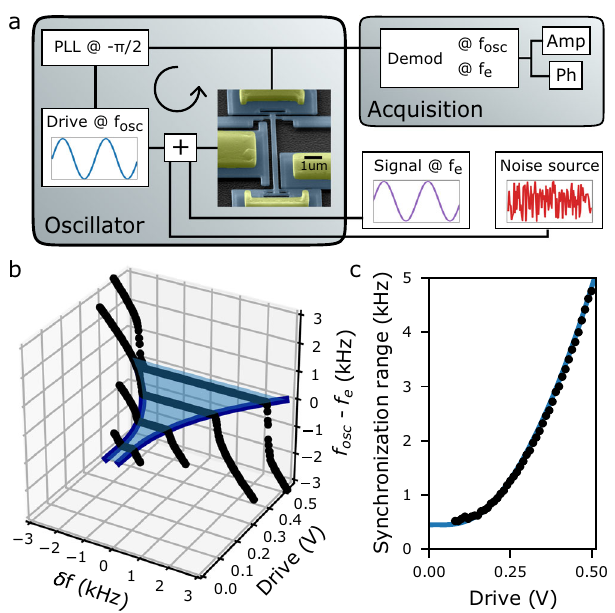
Fig. 1 Experimental setup and synchronization regime. a The resonator (colored scanning electron micrograph of a representative NEMS in inset) is driven as an oscillator at f using a feedback loop (arrow), and is subject osc to an external tone at f e . Using a lock-in ampli fi er, the output signal of the NEMS is demodulated at either f osc or f e to obtain amplitude and phase difference. The noise source is turned off for the synchronization range characterization. b The oscillator gets synchronized and locked to the frequency f e for a suf fi ciently small frequency mismatch δ f ¼ f r (cid:2) f e . c The synchronization range increases quadratically with the drive amplitude in the nonlinear regime. The external tone level is set to 10% of the drive. The experimental black data points are plotted on top of the blue theoretical predictions from the